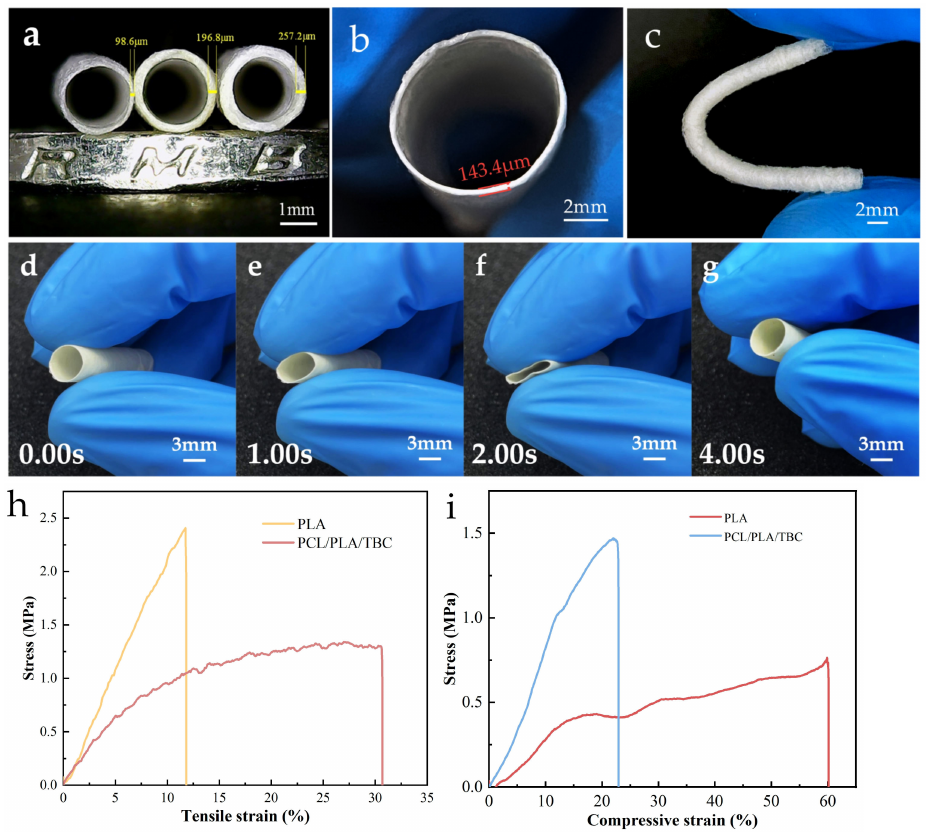
Figure 8. ( a – c ) The tubular microfiber scaffolds with different structures. ( d – g ) Compressive re- silience of tubular microfiber scaffolds. ( h ) Tensile stress–strain of different fiber samples. ( i ) Axial compressive stress–strain of different tubular microfiber